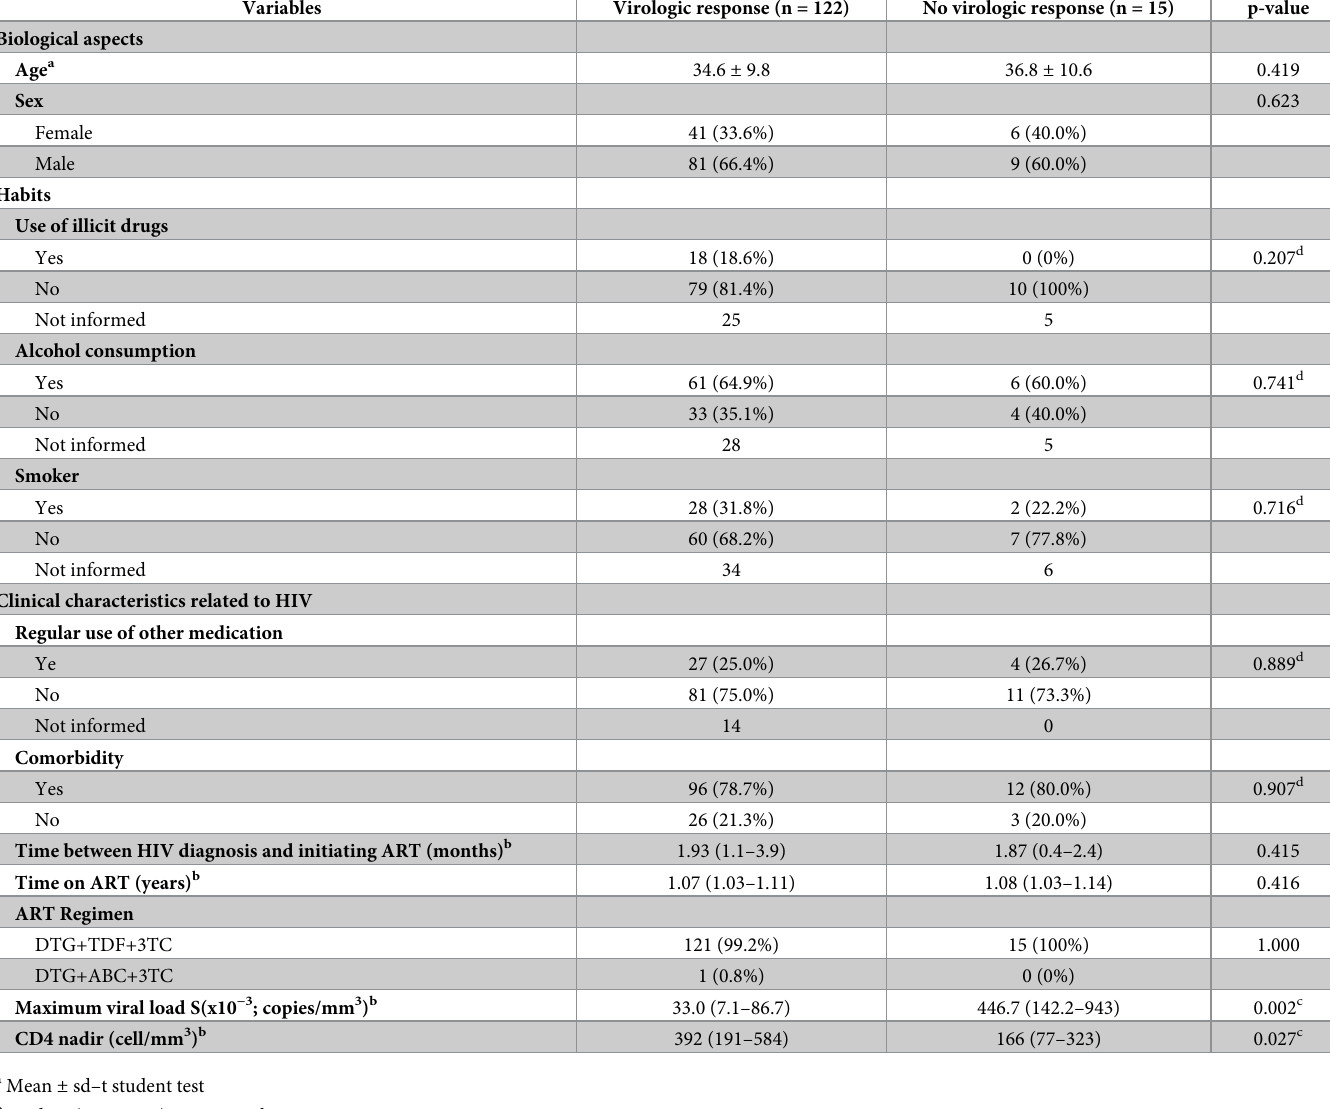
Table 3. Analysis of the association of covariates with the virologic response at week 24 in individuals who initiated the first antiretroviral regimen containing dolutegravir.